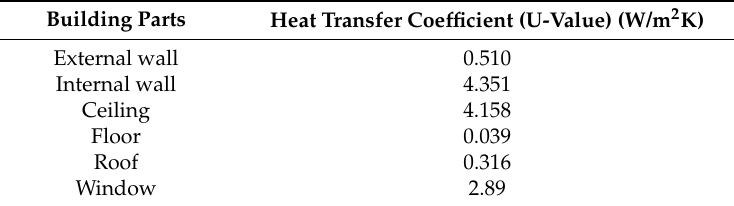
Table 3. Indoor conditions of three building types.